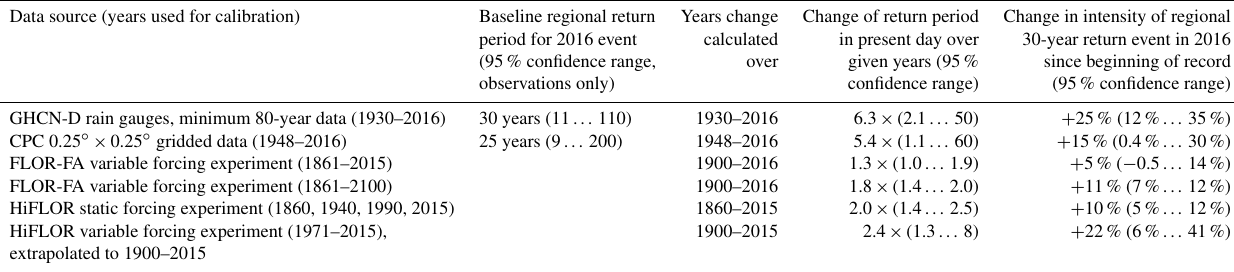
Table 3. Summary of observed (first two rows) and modeled (third row and down) changes in regional rainfall extremes in the central US Gulf Coast. Note that the modeled changes can be attributed to anthropogenic climate change. Data source (years used for